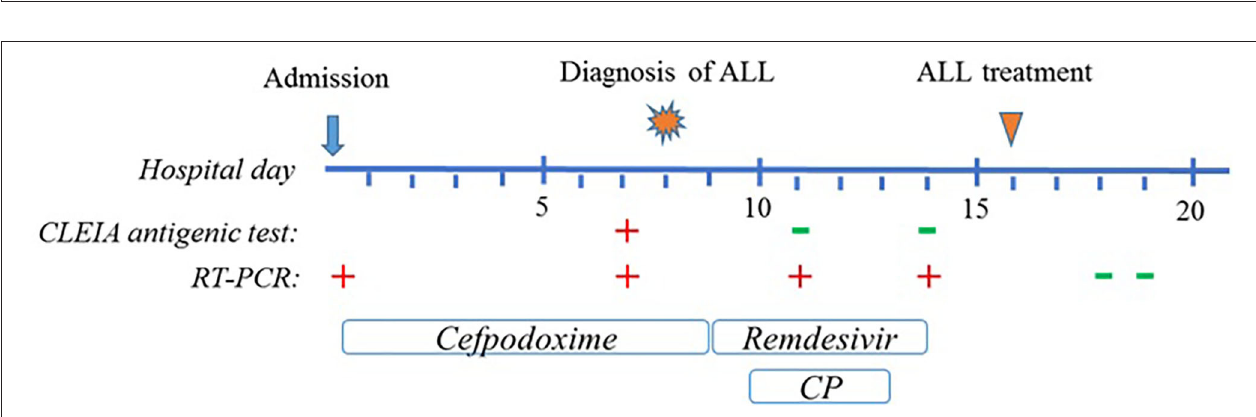
FIGURE 3 | Graphical representation of clinical course of the patient. Timeline includes up to 20 days after admission, until the SARS-CoV-2 molecular test resulted negative. not statistically significant, a recent Italian study supported a potential therapeutic role of CP in subjects with mild-to- moderate Covid-19. To date, only 6 studies have described the